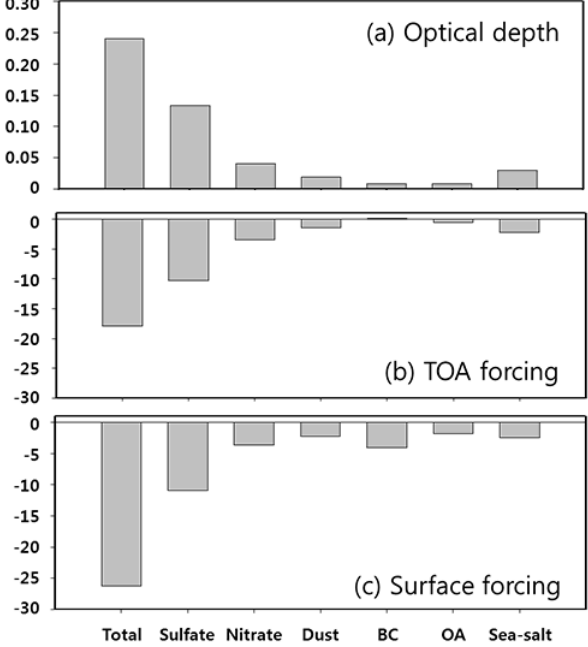
Fig. 15. Same as Fig. 13 but under all-sky conditions.